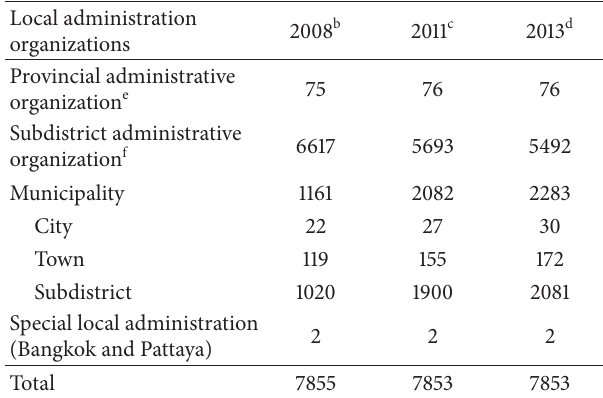
Table 1: Current status of local administration development a across the